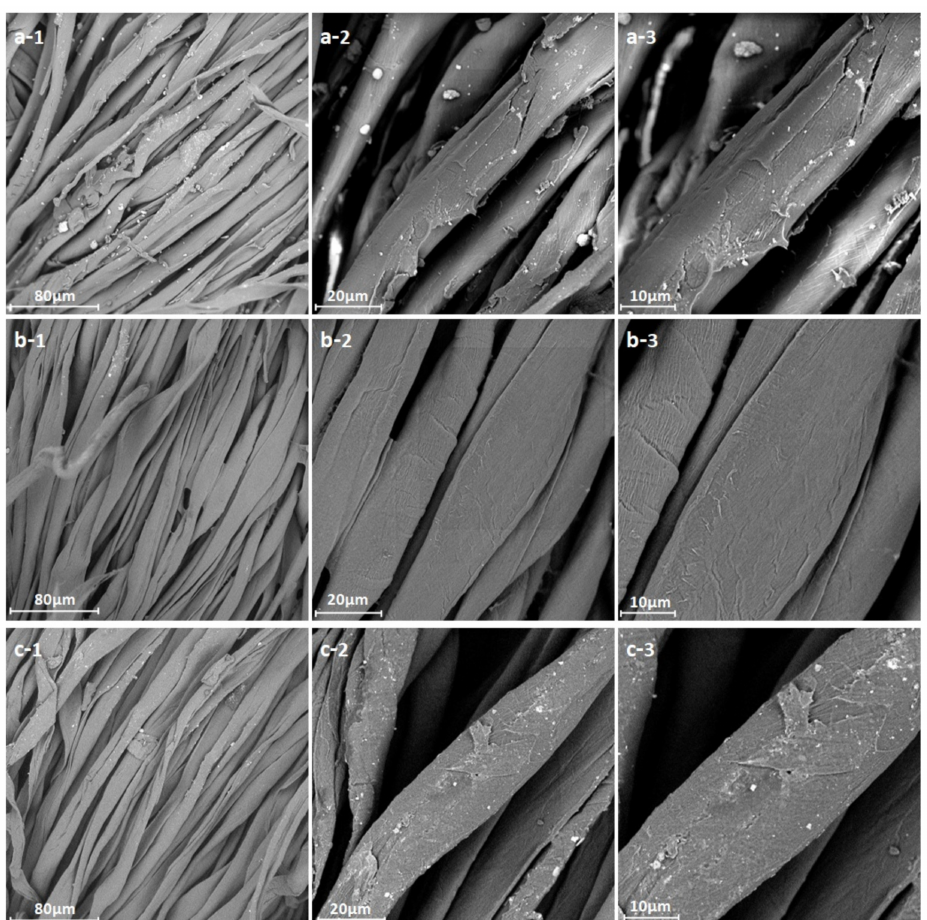
Figure 7. SEM images of the greige and bleached fabric: ( a ) greige, ( b ) fabric bleached using the SPC-activated system and ( c ) fabric bleached using a conventional system; 1, 2 and 3 stand for the magnifications of 1000, 3000 and 5000,